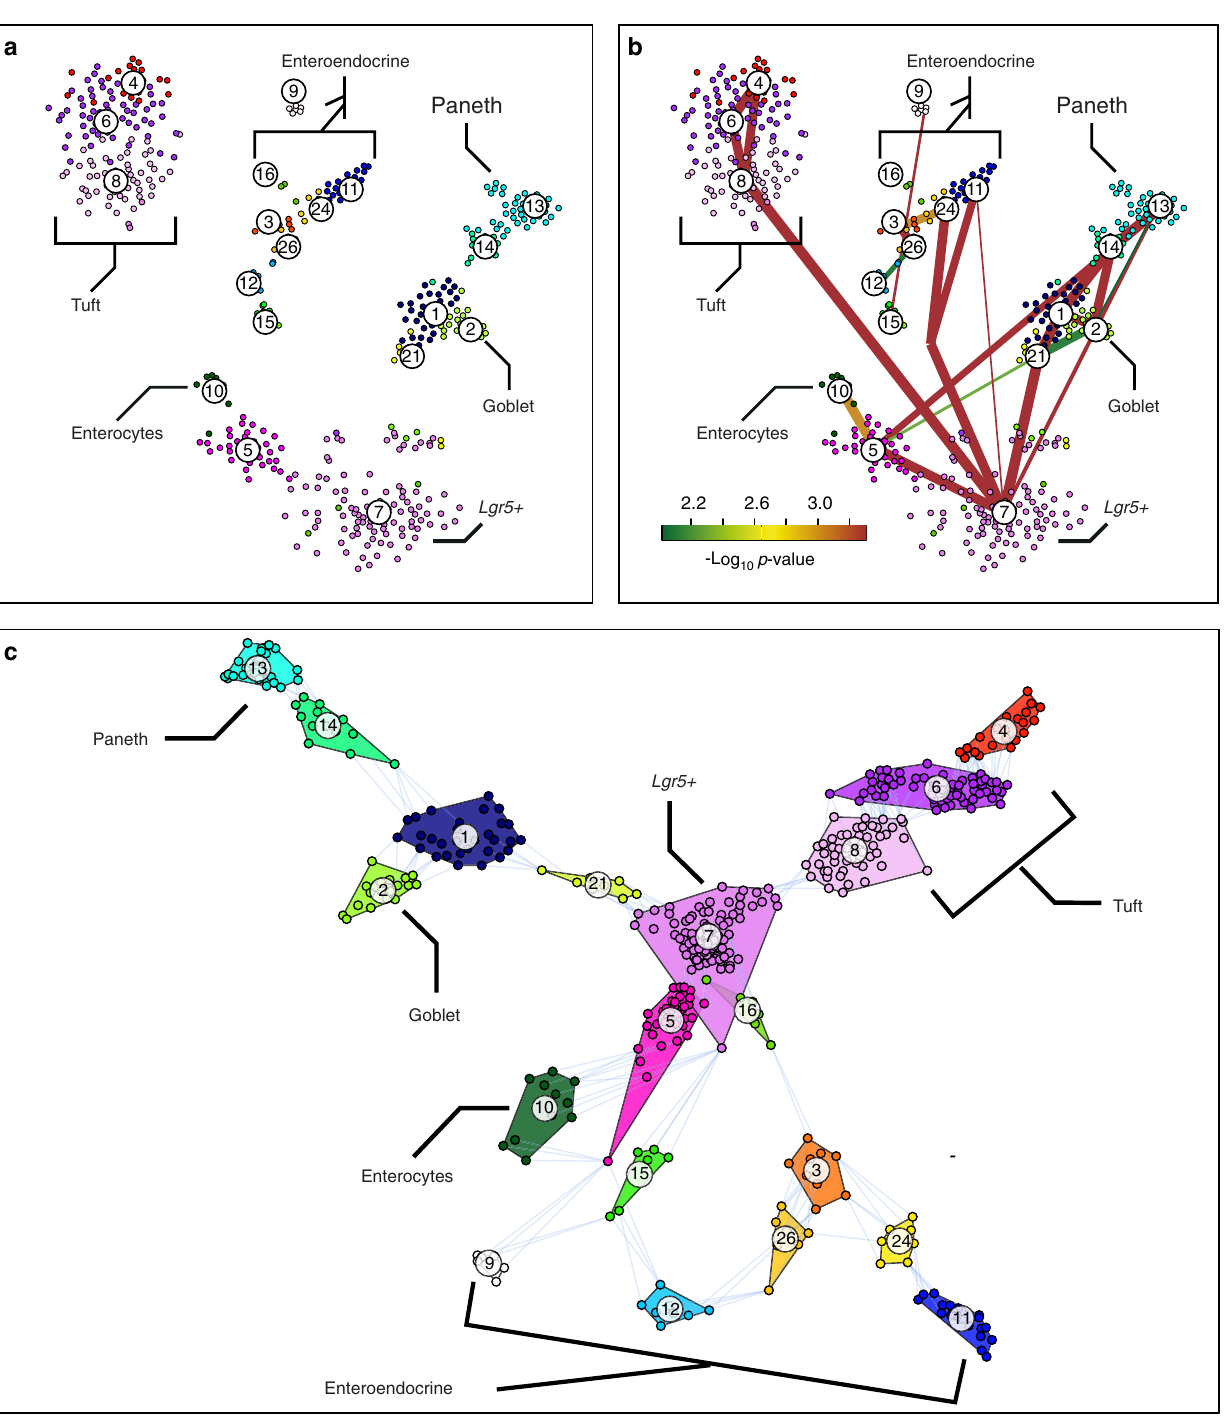
Fig. 2 GraphDDP reveals differentiation trajectories of intestinal epithelial cells. a t-SNE map representation of intestinal epithelial single-cell transcriptome data from Grün et al. 17 . Clusters, highlighted in different colors, were derived by RaceID2 in the original study and correspond to distinct cell types or progenitor stages. b The lineage tree inferred by StemID is overlaid on cell clusters. Thicker links re fl ect higher coverage of a link by cells, and the color re fl ects the signi fi cance of a link measured by a logarithmic p -value. The lineage tree was found to be in good agreement with the current model of intestinal cell differentiation. c Visualization of the intestinal epithelial data by GraphDDP. The convex hull of each cluster is shown and shift edges are depicted to re fl ect the relations between clusters. The representation places stem cells in the center, recapitulates the differentiation trajectories shown in b and identi fi es novel lineage-speci fi c progenitor relations (see